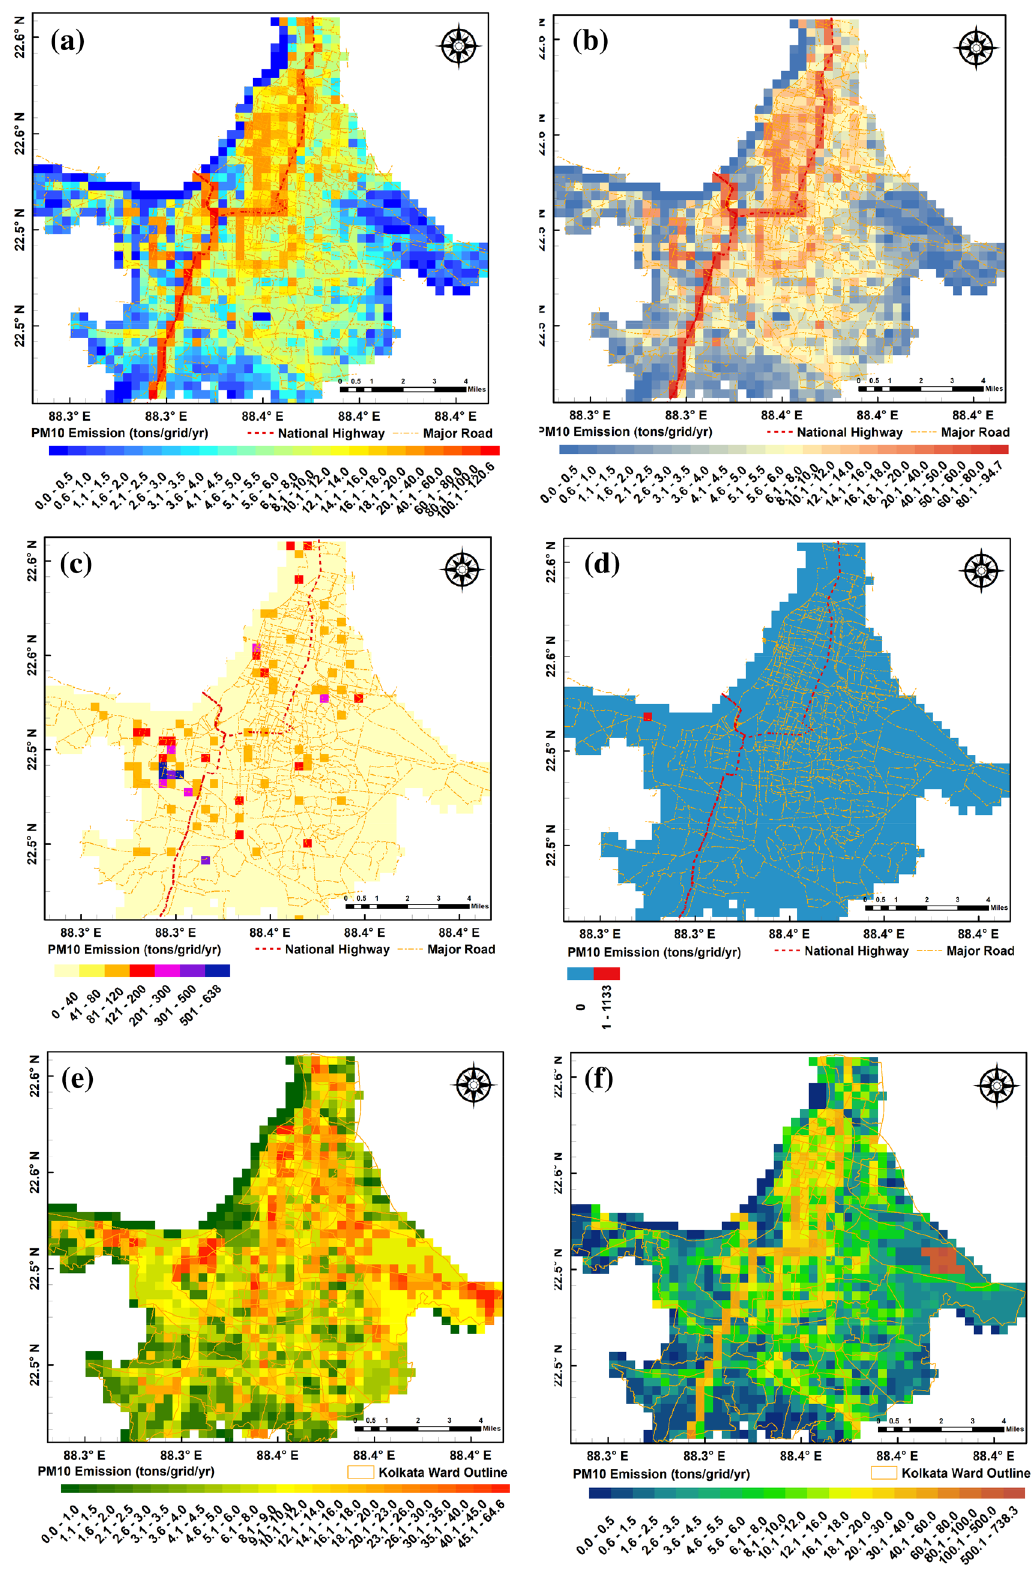
Fig. 4 Sector specific gridded annual PM tial f